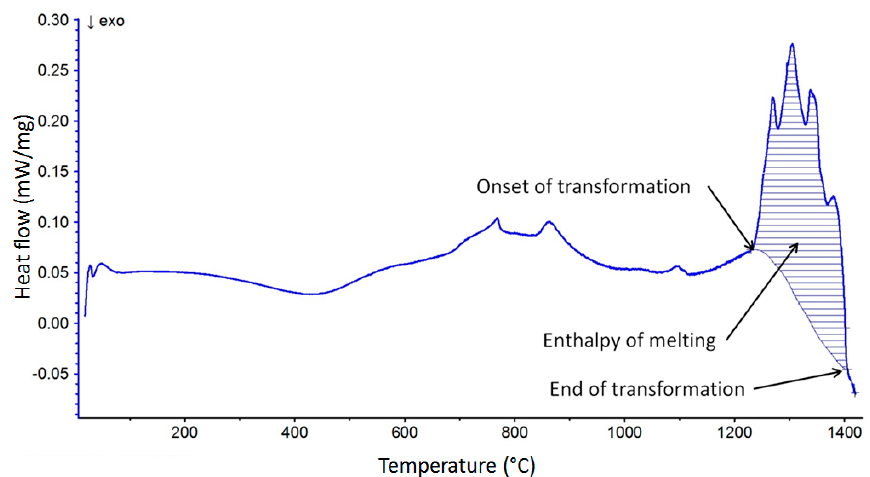
Figure 6. Thermophysical properties of HSS M4: ( a ) thermal capacity ( c p), ( b ) thermal conductivity ( k), and ( c ) density ( ρ ) .